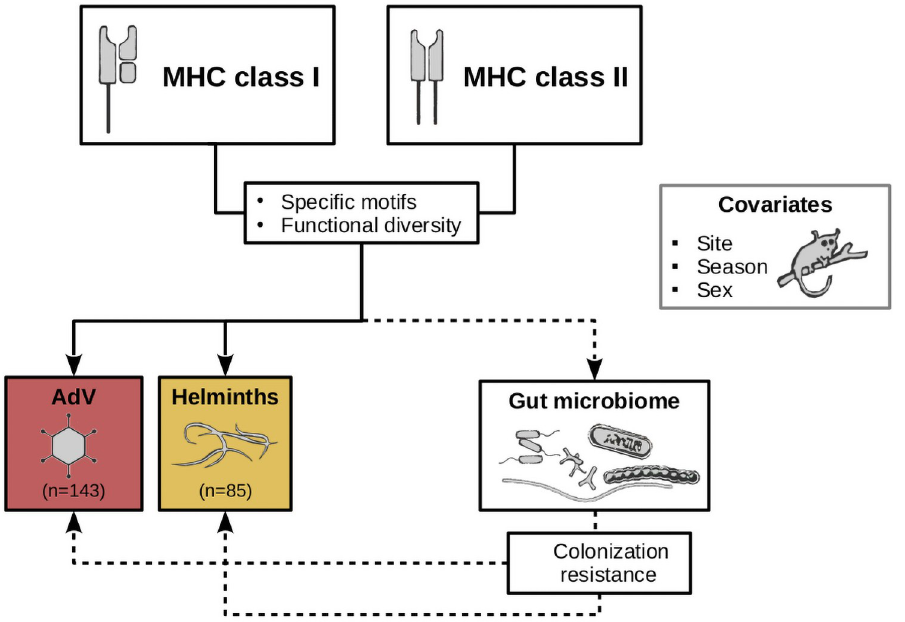
Fig 1. Study design. The role that MHC polymorphisms may play on parasite infection status in natural populations can be better understood under the lens of their direct and indirect contribution. The MHC may have direct effects on parasite infection via antigen-driven immune response. It may also indirectly affect the environment that parasites face when establishing an infection by shaping the gut microbiome. We evaluated the direct (solid arrows) and indirect (dashed arrows) contribution that MHC class I and class II diversity may have on micro- (adenovirus, AdV) and macro-parasite (helminths) infection status in a wild population of non-human primates, the mouse lemur M. griseorufus , while controlling for the effect of extrinsic (sampling site and season) and intrinsic (sex) factors. We assessed MHC diversity in terms of the presence of specific motifs (MHC class I supertypes and MHC class II alleles) and functional diversity (sequence divergence and number of supertypes). We evaluated the direct effects of the MHC on infection status according to the following predictions: i) specific MHC class I supertypes and MHC class II alleles will be associated with susceptibility (or resistance) to AdV and helminth infection, respectively; ii) functional diversity will be negatively associated with parasite infection status. For the indirect effects of the MHC on infection status via the microbiome, we predicted that MHC I and MHC II diversity influences the diversity and the composition of the microbiome. In particular we predicted that specific MHC motifs and MHC functional diversity will be negatively associated with the relative abundance of pathogenic taxa. In contrast, we expect to find that taxa not subject to immune recognition mediated by the MHC are involved in essential metabolic functions and contribute to resistance to parasitic